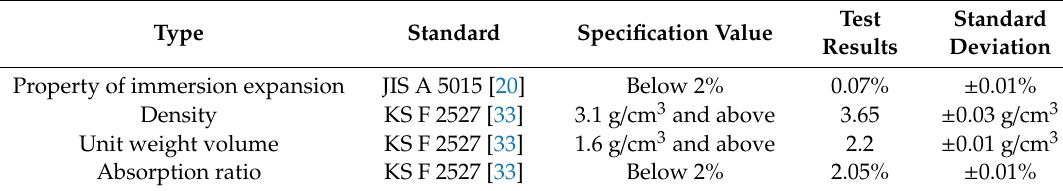
Table 4. Physical properties of the steel slag.